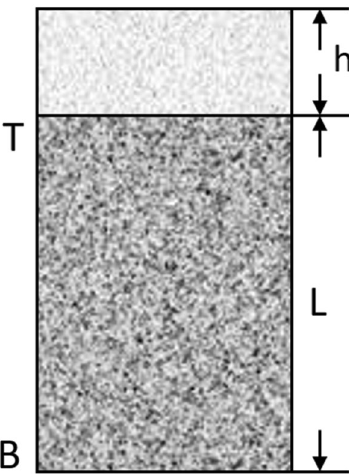
Figure 2. Hypothetical description of soil leachate transport in a unit soil